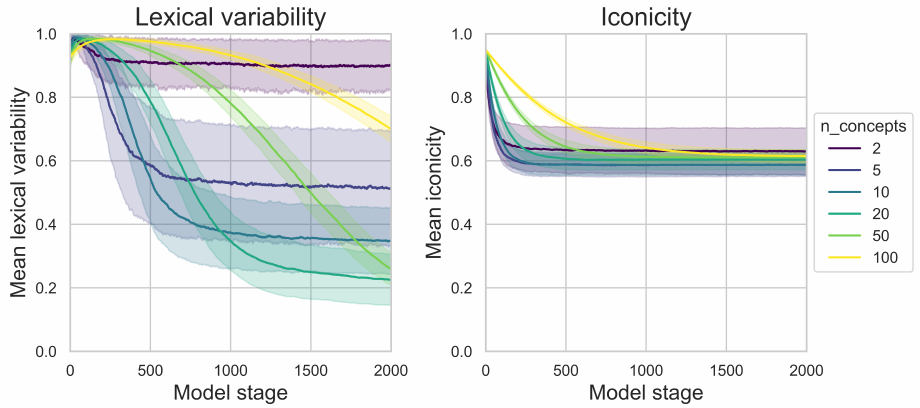
Figure A2. The mean lexical variability over the 2000 model stages for numbers of concepts ( n_concepts ): 1, 5, 10, 20, 50, 100. The dark line represents the mean and the shaded area repre- sents the standard deviation of the 100 repetitions. When there are more concepts, the initial value of lexical variability increases. While the runs with few concepts quickly stabilize at a fairly high degree of lexical variability, the runs with more concepts have a lexical variability value which continues to decrease. The degree of iconicity is comparable across runs with different numbers of concepts, though runs with more concepts retain a higher degree of iconicity longer before